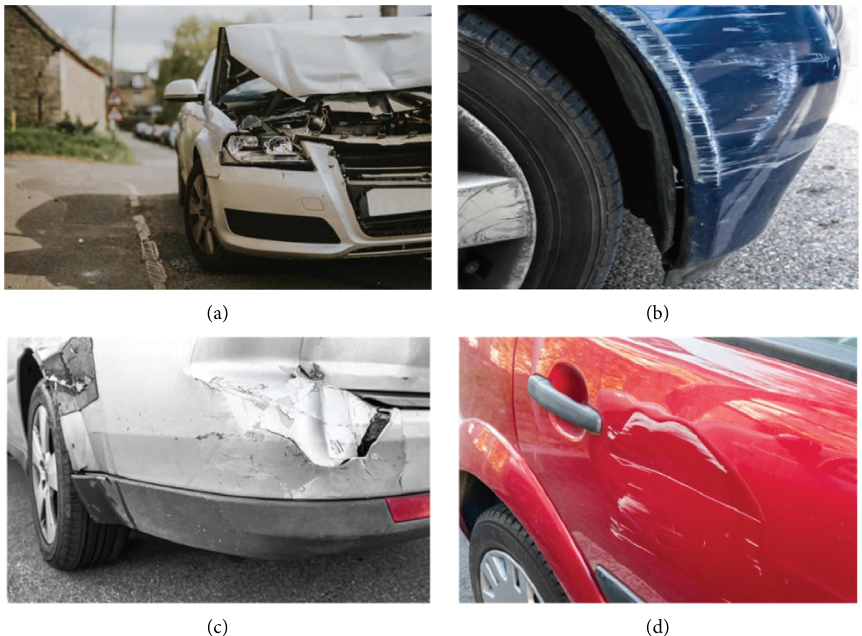
Figure 2: Various damage categories with variable repair outcomes including (a) deformed/missing parts, (b) scratches, (c) major dent, and (d) scratch-and-dent